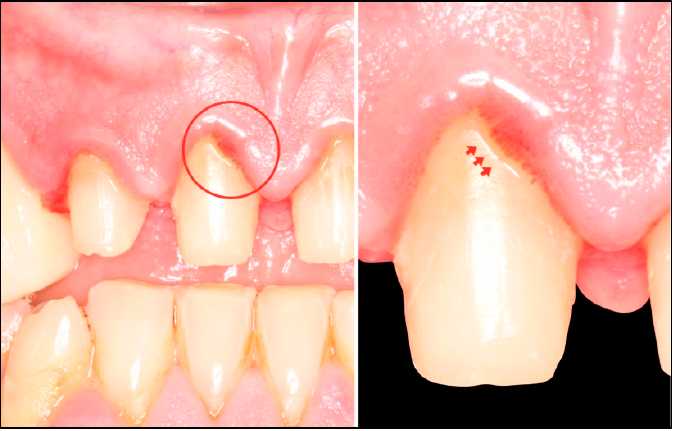
Figure 7. Temporization and periodontal tissue healing of new preparations: ( 7a ) adaptation of new Figure 8. After lifting the temporary crowns, creeping attachment can be observed at the marginal temporary crowns; ( 7b ) review appointment 2 months after temporary crowns placement; optimal level of the soft tissues. periodontal healing can be observed.